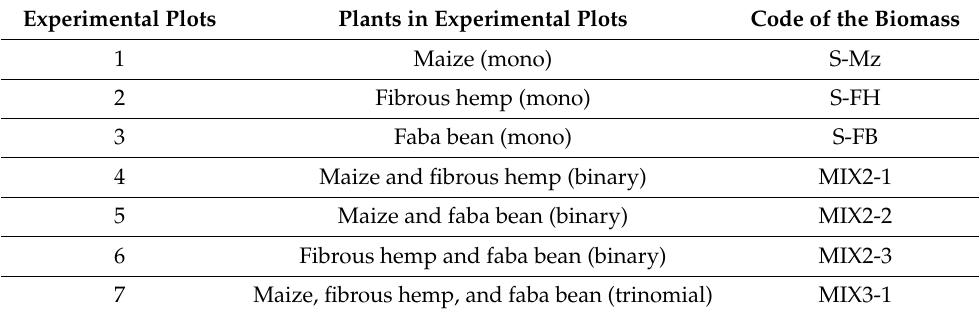
Table 1. Plant growing in monocultures and multi-crop. Experimental Plots Plants in Experimental Plots Code of the Biomass 1 Maize (mono) S-Mz 2 Fibrous hemp (mono) S-FH 3 Faba bean (mono) S-FB 4 Maize and fibrous hemp (binary) MIX2-1 5 Maize and faba bean (binary) MIX2-2 6 Fibrous hemp and faba bean (binary) MIX2-3 7 Maize, fibrous hemp, and faba bean (trinomial)